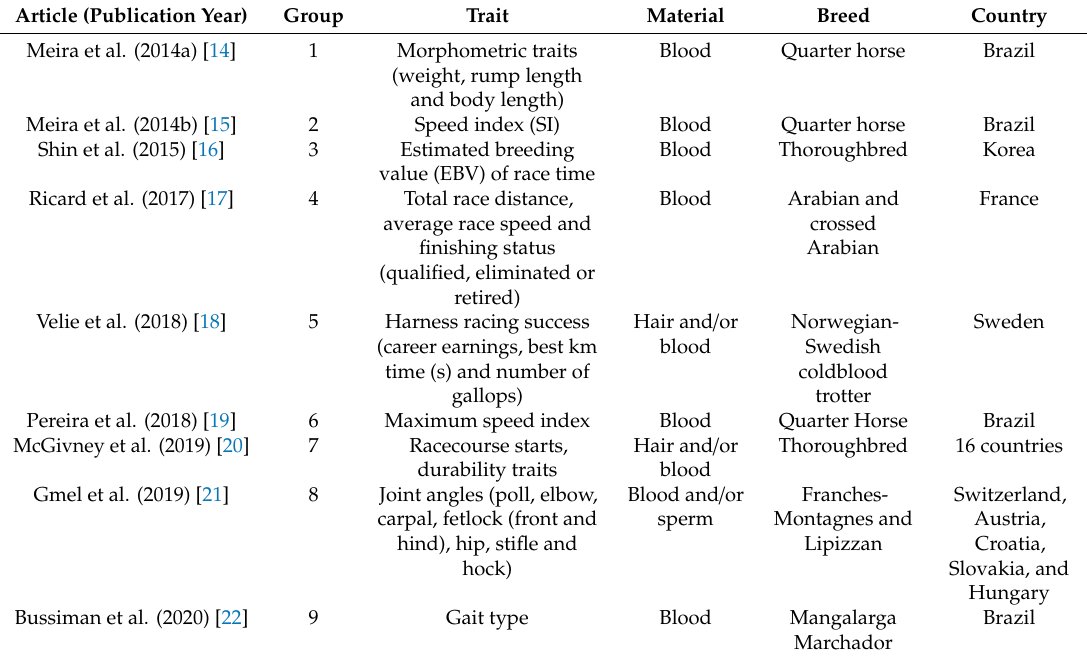
Table 1. Country, breed, sample constitution and trait information from selected